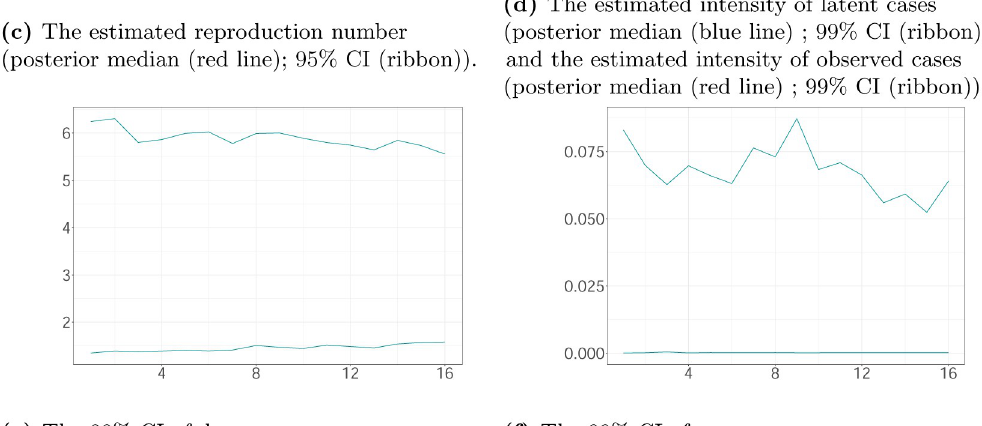
Fig 7. The weekly and daily latent cases, the reproduction number, the latent and observed intensity and the 99% CIs of time-constant parameters in Ashford plotted against time. The time interval between two successive pink vertical dashed lines corresponds to a week. (a) The estimated weekly latent cases (posterior median (black line); 99% CI (ribbon)), and the weekly observed cases (cyan line). (b) The estimated daily latent cases (posterior median (black line); 99% CI (ribbon)), and the daily observed cases (cyan line). (c) The estimated reproduction number (posterior median (red line); 95% CI (ribbon)). (d) The estimated intensity of latent cases (posterior median (blue line); 99% CI (ribbon)) and the estimated intensity of observed cases (posterior median (red line); 99% CI (ribbon)). (e) The 99% CI of d. (f) The 99% CI of